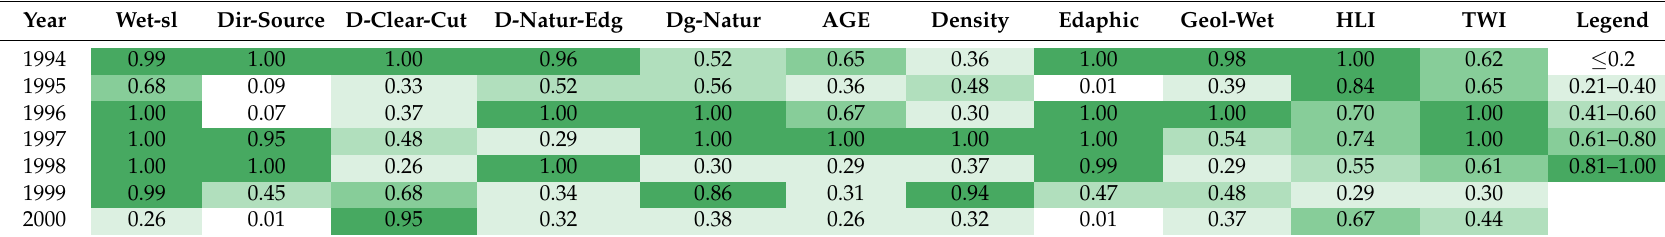
Table A1. Predictor importance weights based on multimodel inference when only the Wetness slope is used with the environmental predictors. The darkest/lightest green show the highest/lowest predictor importance weights.